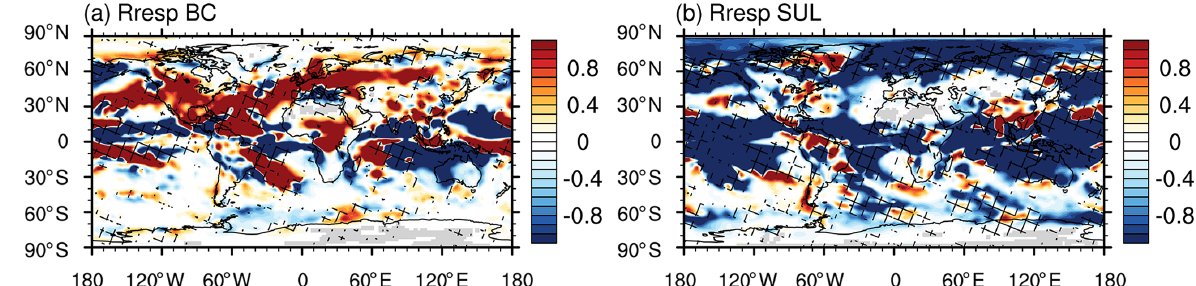
Figure 2. Response ratio of fast and slow responses ( R resp ) (red denotes fast responses dominate the total responses and blue indicates slow responses dominate) for (a) BC cases and (b) SUL cases. Results have been normalised by total responses of precipitation. Hatching indicates the signs of fast and slow responses are same. If R resp is around 0, contributions from fast and slow responses are similar. If R resp is larger than 0, the total response is dominated by fast responses. If R resp is less than 0, the total response is dominated by slow responses.